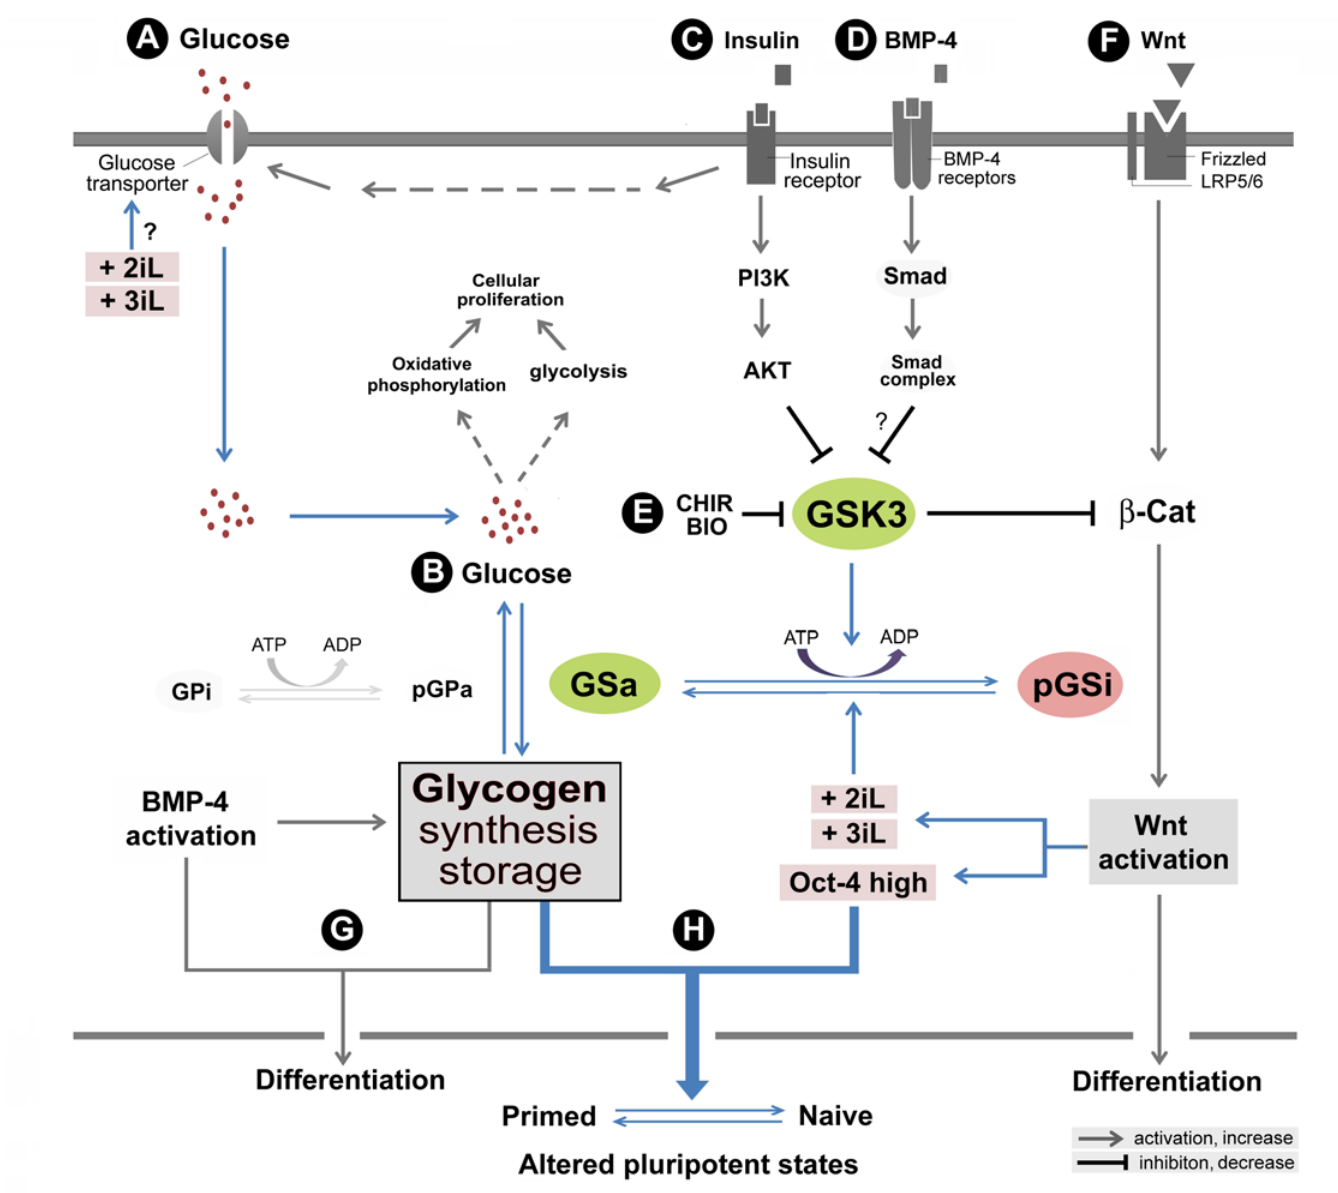
Fig 9. Growth, differentiation, and glycogen synthesis in human embryonic stem cells (hESCs). A hypothetical model is presented to elucidate major signaling pathways that are associated with glycogen synthase kinase 3 (GSK-3) and glycogen synthesis. ( A) In this model, glucose transporter-mediated uptake of glucose is activated by an insulin-receptor signaling pathway. ( B ) Glucose takes part in aerobic glycolysis in the cytoplasm and oxidative phosphorylation in mitochondria to produce energy for hESC proliferation and self-renewal. Presumably, excessive glucose is converted to glycogen by activated glycogen synthase (GSa) upon stress and differentiation signaling to enhance hPSC survival. Glycogen can be decomposed in the presence of phosphorylated glycogen phorsphoylase (pGP) whenever necessary. ( C ) The insulin signaling pathway also activates the PI3K-AKT pathway, which phosphorylates GSK-3. The GSK-3 phosphorylation leads to its inactivation and subsequently inhibits the phosphorylation of glycogen synthase (GS). Thus, activation of the PI3K-AKT pathway increases glycogen synthesis. ( D ) The mechanism of BMP-4-induced glycogen body formation is likely through the inhibition of GSK-3 by the putative Smad pathways. ( E ) The mechanism by which the GSK3i CHIR modulates the synthesis of glycogen is likely through the inhibition of GSK-3 activity, thereby altering glycogen synthase activity. ( F ) Concomitantly, GSK-3 inhibitors (e.g., CHIR99021 and BIO) may promote hPSC differentiation by activation of the β -catenin-WNT pathway. ( G ) The function of aggregated glycogen bodies is unclear and may be associated with response to extracellular stress and differentiation signals such as BMP-4. ( H ) Under sustained Oct-4 expression conditions, GSK3i-mediated glycogen accumulation concomitant with Wnt activation and other na ï ve growth components enhances the transition from the primed pluripotent to the na ï ve state in hPSCs. The proposed mechanisms in this model supported by this study are color-highlighted. The “ ? ” symbols indicate inconclusive observations. The abbreviations are: 2iL, the na ï ve pluripotent growth condition that include GSK3i, MEKi, and LIF; 3iL, the na ï ve pluripotent growth condition that include GSK3i, MEKi, BMP4i, and LIF; AKT, the serine-threonine protein kinase encoded by v-akt murine thymoma viral oncogene homolog; CHIR, CHIR99021;